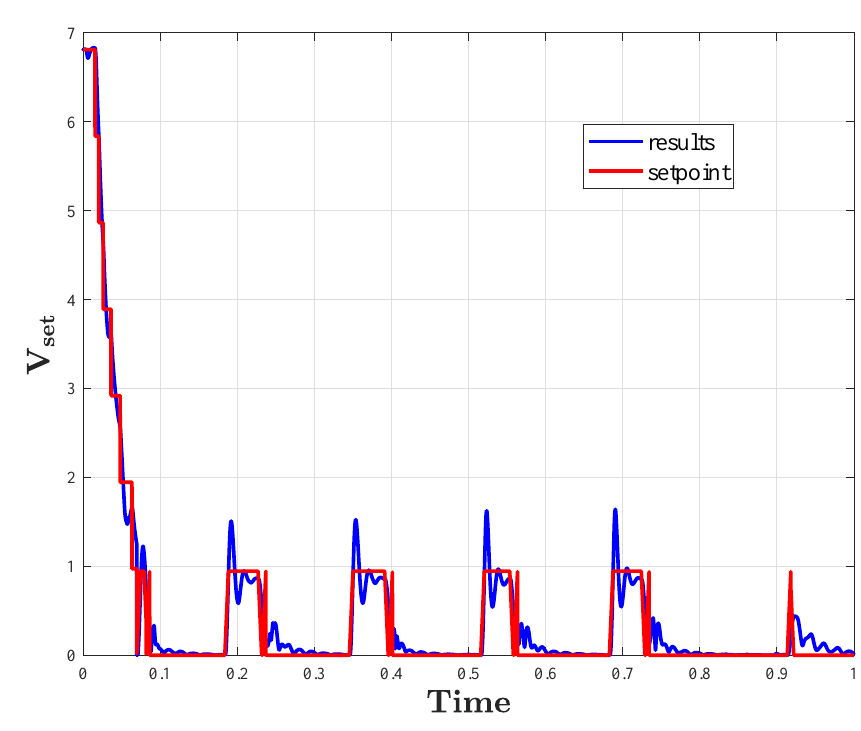
Figure 15. From blue to narrow water: vessel